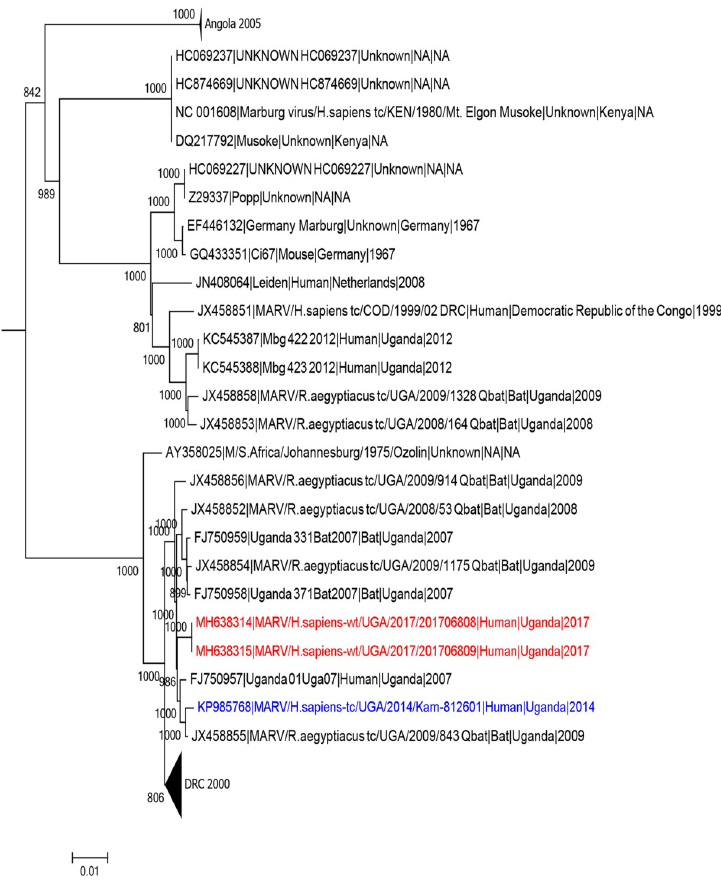
Fig 4. Phylogenetic tree inferring the relationship of Marburg virus from the 2017 outbreak with previous MVD outbreaks in